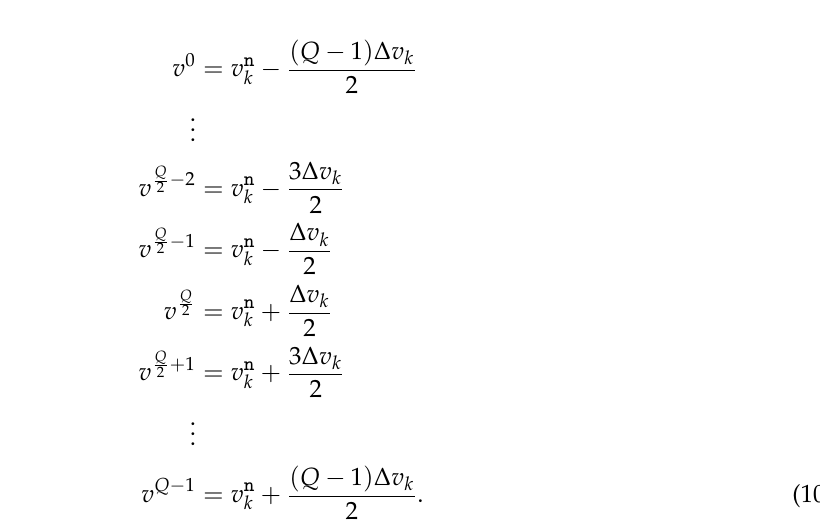
= 400 V , r n = r n = 2 Ω , v 0 = 398 V , v 1 = 402 V , b d , a d , b